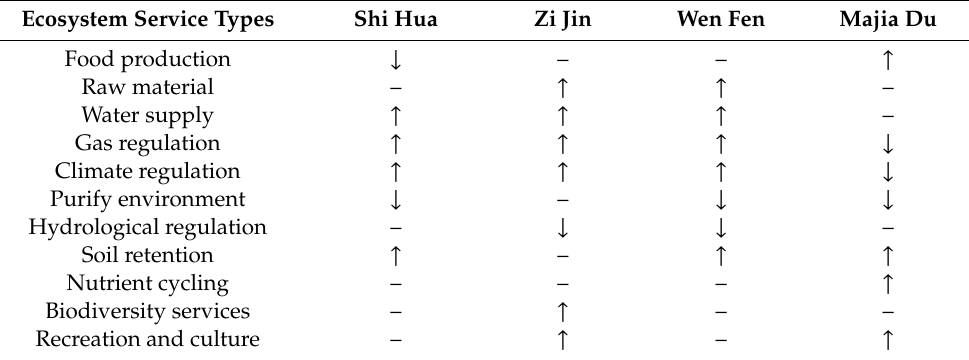
Table 4. Perceived decreases or increases in ecosystem services for each village. Ecosystem Service